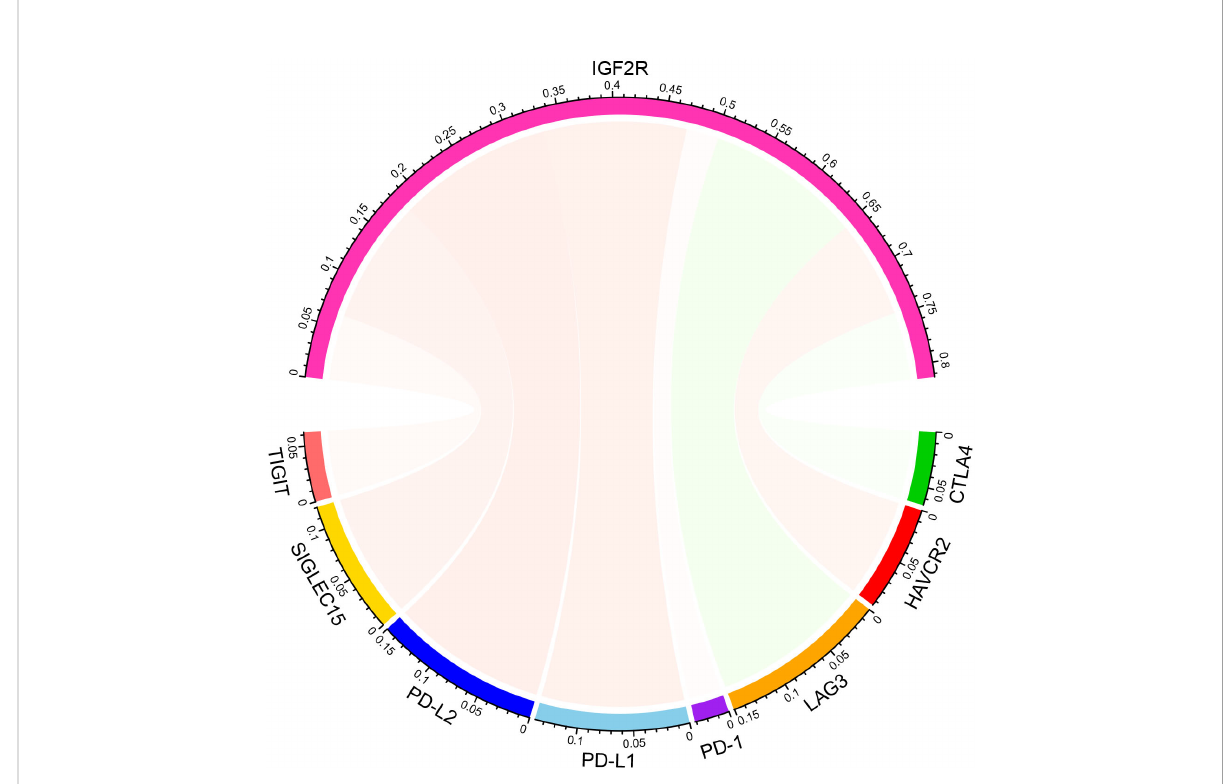
FIGURE 4 Correlations between expressions of IGF2R and eight important immune checkpoint